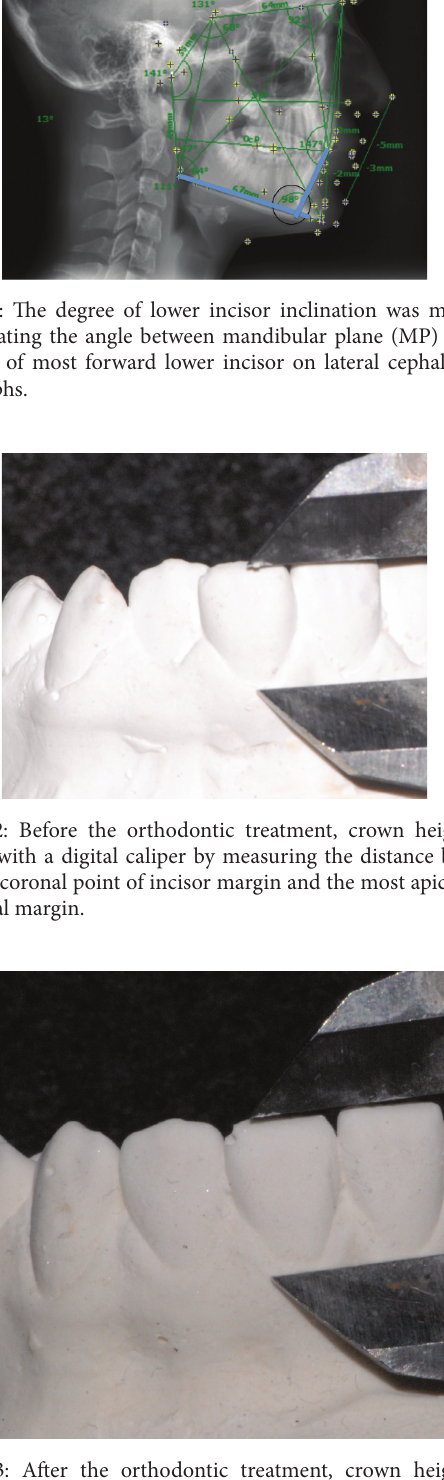
Figure 3: After the orthodontic treatment, crown height was assessed with a digital caliper by measuring the distance between the most coronal point of incisor margin and the most apical point of gingival